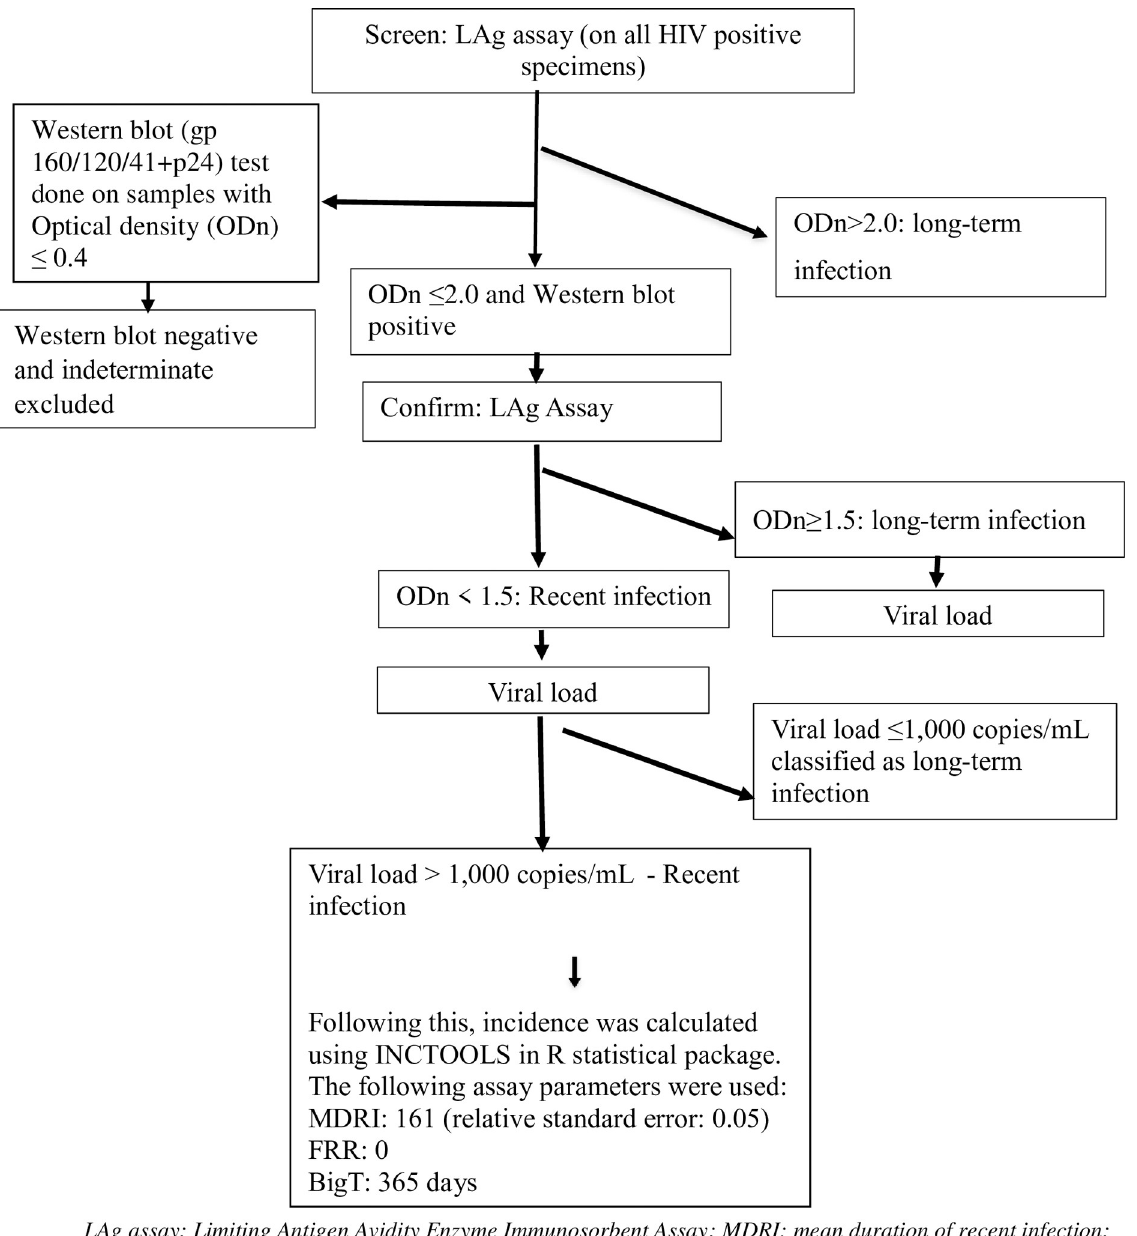
Fig 2. Recent infection testing algorithm (RITA1) in the 2017 Antenatal HIV Sentinel Survey, South Africa.